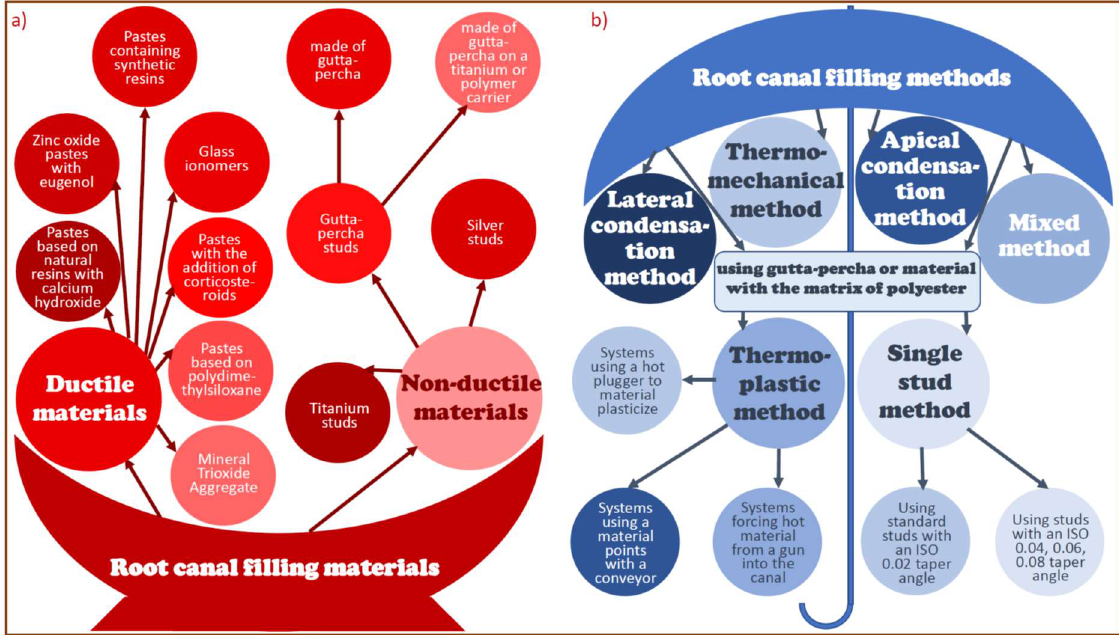
Figure 2. Scheme: ( a ) ikebana full of all types of root canal filling materials; ( b ) umbrella surrounding all types of root canal filling methods.